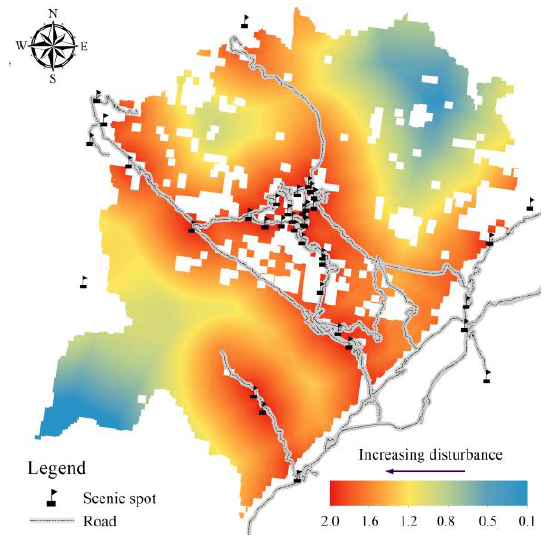
Figure 4. Distribution of disturbance across the Huangshan UNESCO Global Geopark ranging from 0.1 to 2.0, which represents an increasing influence.